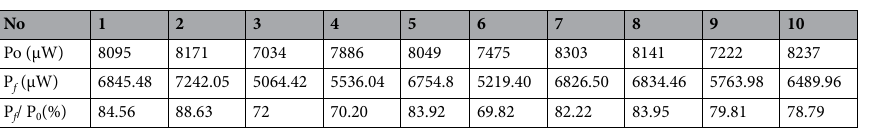
Table 3. Experimental measurement of coupling